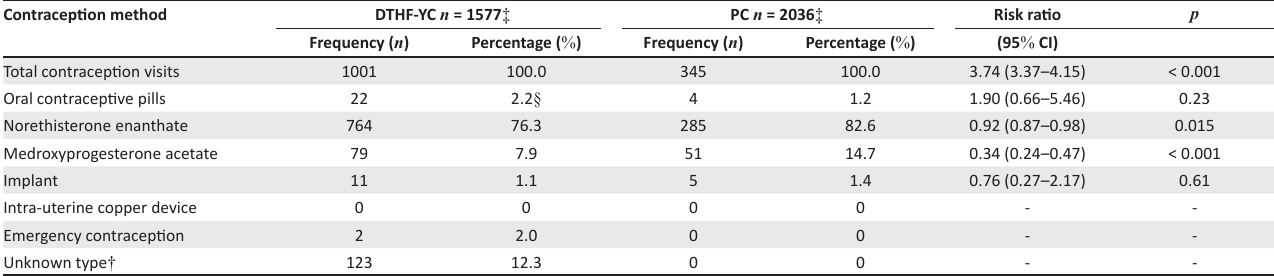
TABLE 1: 2015 Contraception visits in female adolescents aged ≤ 18 years at Desmond Tutu HIV Foundation Youth Centre versus public clinic. Contraception